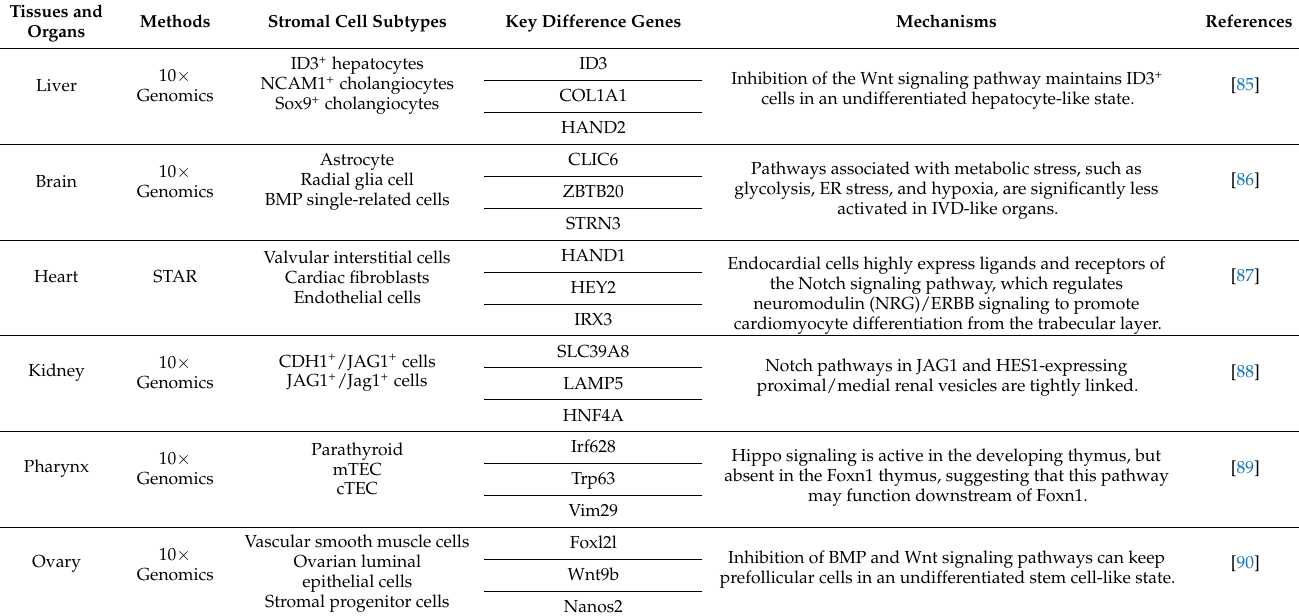
Table 2. Latest applications of ScRNA-Seq in tissue and organ